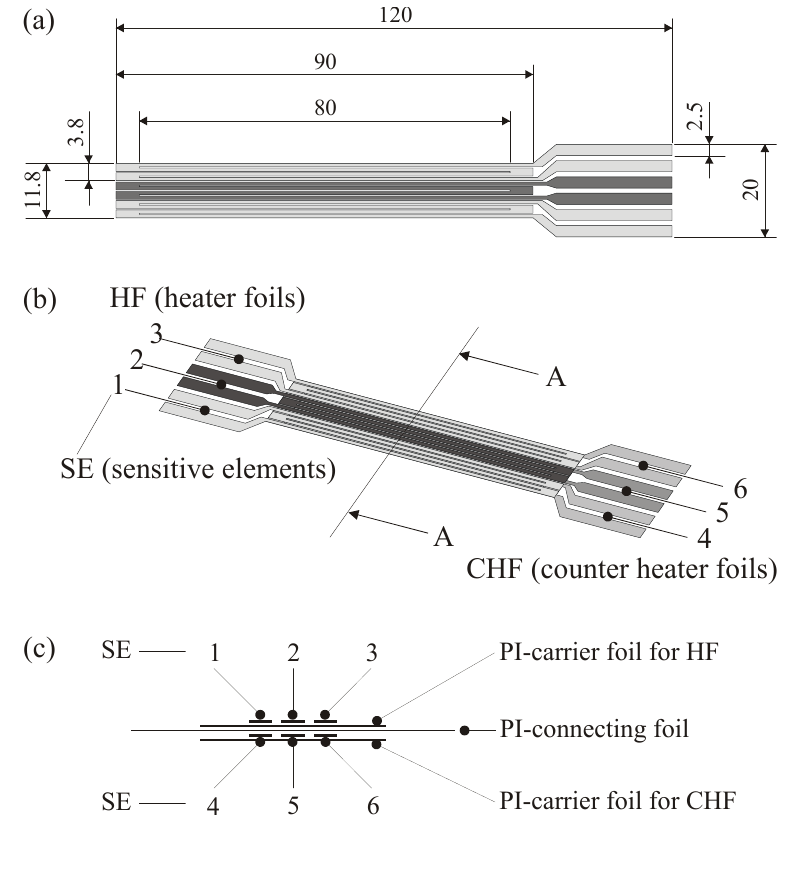
Figure 5. Details of the design for the advanced sensor (thin foil triple sensor). (a) photo mask. (b) combination of the numbered heater and counter heater elements. (c) cut along A-A in (b)